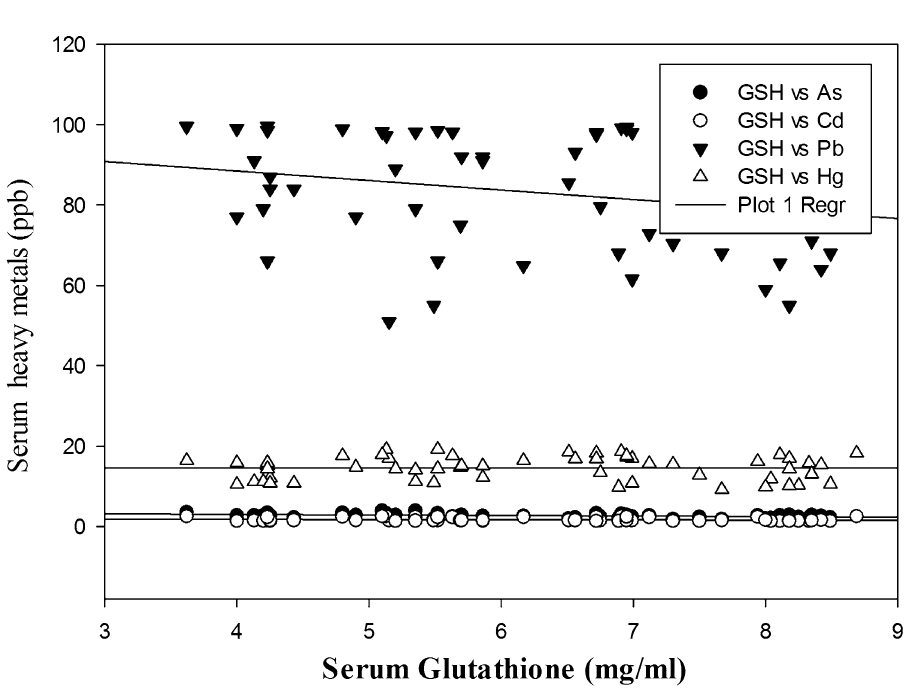
Figure 2. Multiple regression plot of heavy metals and GSH in PCOS